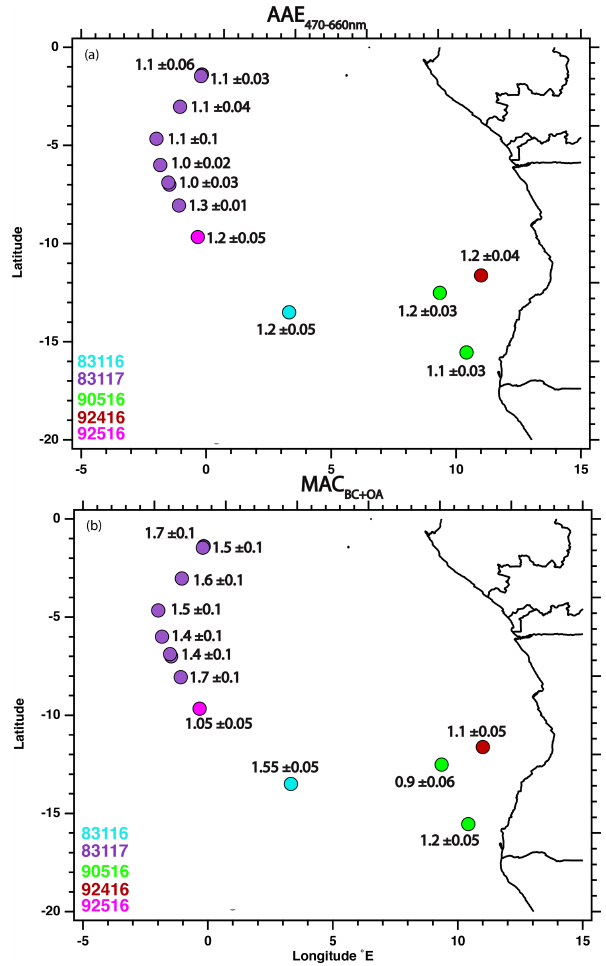
Figure 11. (a) Absorption Ångström exponent (470–660nm) and (b) MAC OA + BC , 470 (m 2 g − 1 ) for the same level legs shown in Figs. 9–10, similarly colored by flight